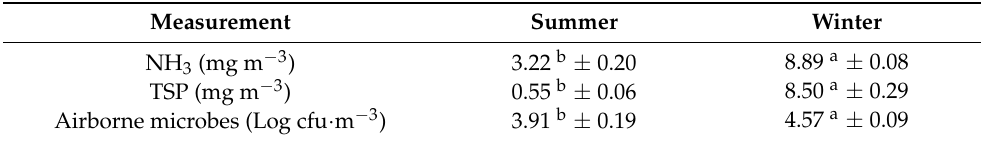
Table 2. Summary of measurement variables during summer and winter weeks.